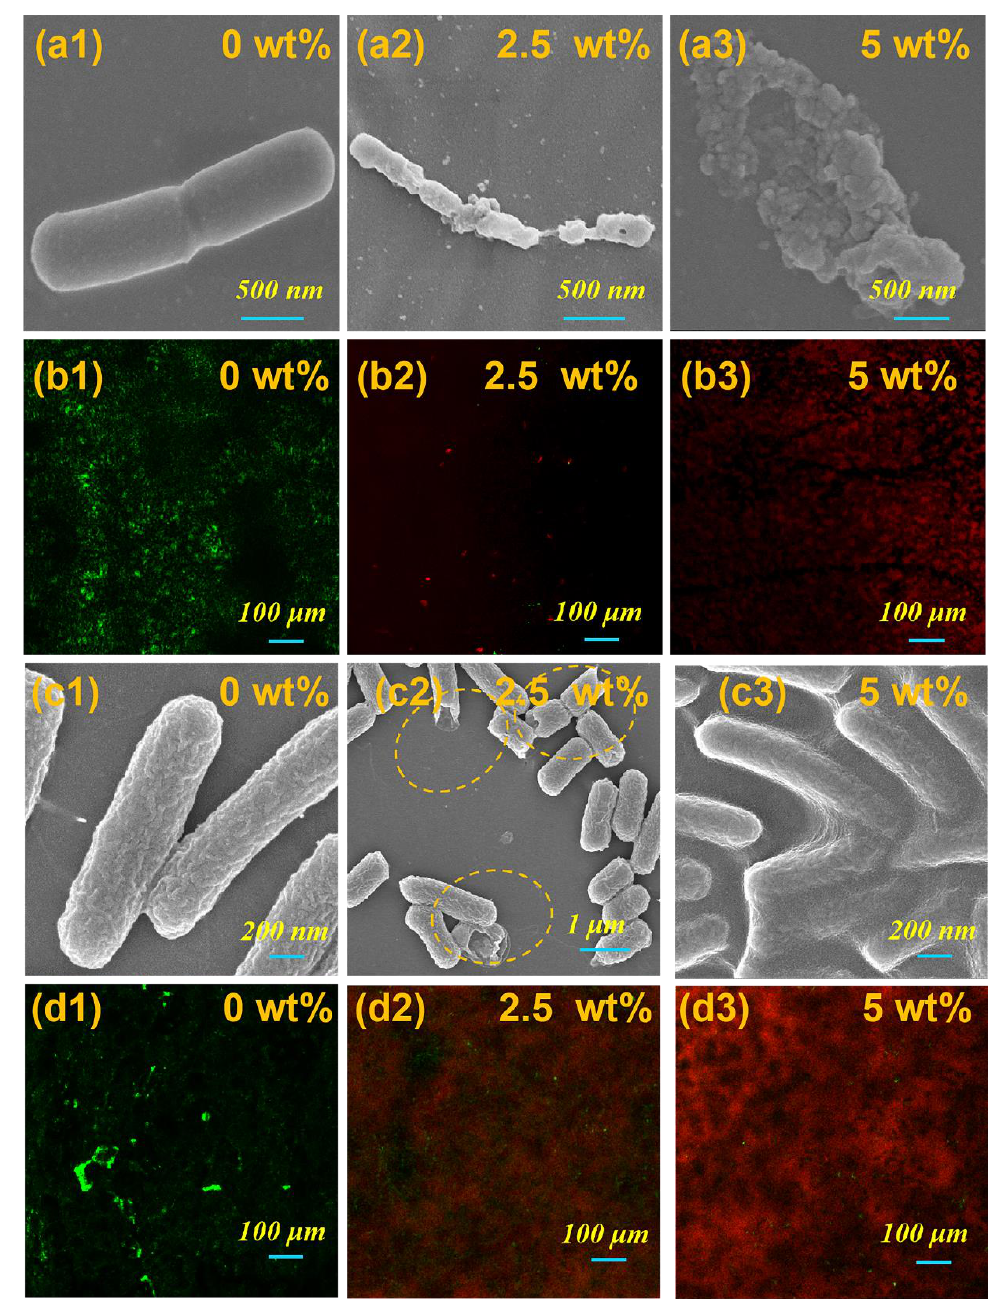
Figure 4. The SEM morphology ( a1 : 0 wt%, a2 : 2.5 wt%, a3 : 5 wt%) and live/dead cell staining ( b1 : 0 wt%, b2 : 2.5 wt%, b3 : 5 wt%) of Bacillus subtilis after touching ZIF-L/epoxy composites with different contents of ZIF-L; The SEM morphology ( c1 : 0 wt%, c2 : 2.5 wt%, c3 : 5 wt%) and live/dead cell staining ( d1 : 0 wt%, d2 : 2.5 wt%, d3 : 5 wt%) of Escherichia coli after touching ZIF-L/epoxy composites with different contents of ZIF-L.